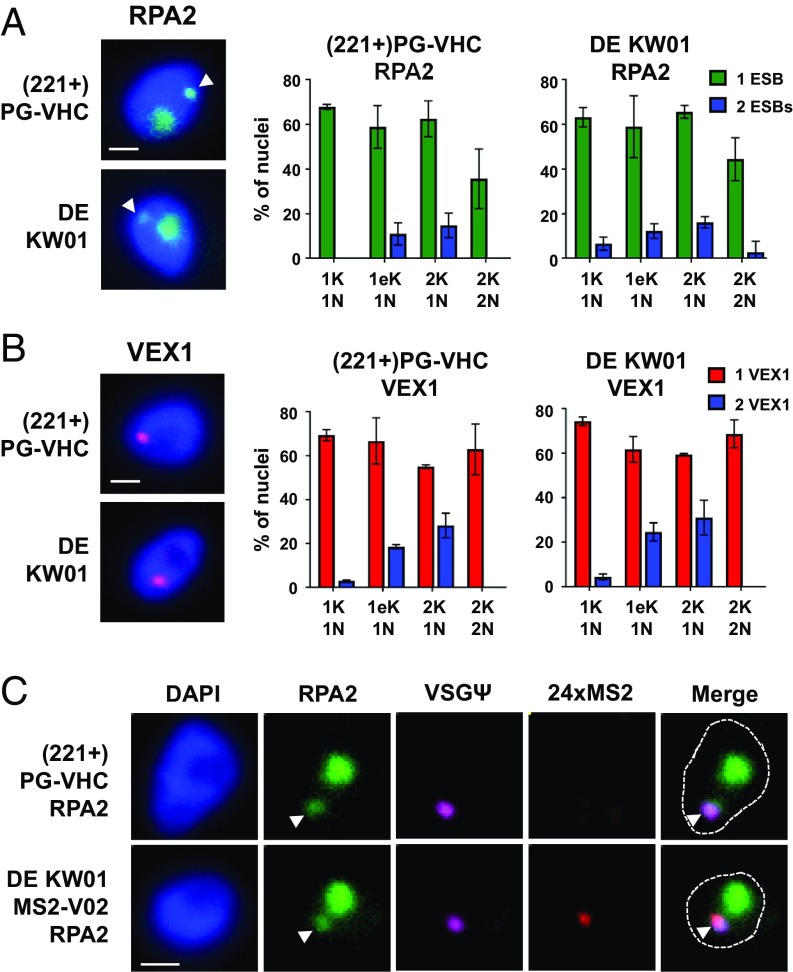
Double-expresser DE KW01 cells predominantly contain a single Pol I and VEX1 focus, which is the location of transcription of the simultaneously active ESs. (A) Immunofluorescence microscopy analysis of single-expresser (221+)PG-VHC or double-expresser KW01 cells expressing the Pol I subunit RPA2 tagged with mNeonGreen (mNG::RPA2). The extranucleolar ESB is indicated with an arrowhead. The percentage (%) of nuclei containing 1 or 2 ESB foci is indicated for cells at different stages of the T. brucei cell cycle, with the number of kinetoplasts (K), elongated kinetoplasts (eK), or nuclei (N) indicated below. Values shown are the average ± SD of 3 biological replicates. The number of cells counted is greater than or equal to 300, 70, 50, and 30 nuclei for the 1K1N, 1eK1N, 2K1N, or 2K2N stages, respectively. (Scale bars: 1 µm.) (B) As in A, only the single-expresser (221+)PG-VHC or double-expresser KW01 cells have VEX1 tagged with the 12× myc epitope. (C) Fluorescence microscopy analysis of epitope-tagged Pol I subunit RPA2 mNG::RPA2 (green) together with RNA FISH probing for VSGΨ (magenta) or 24× MS2 repeat (red) nascent transcripts in the single-expresser (221+)PG-VHC or double-expresser DE KW01 lines containing mNG::RPA2. DNA is stained with DAPI, with the nucleus indicated with a dotted line and the ESB with a white arrowhead. (Scale bars, 1 µm.)